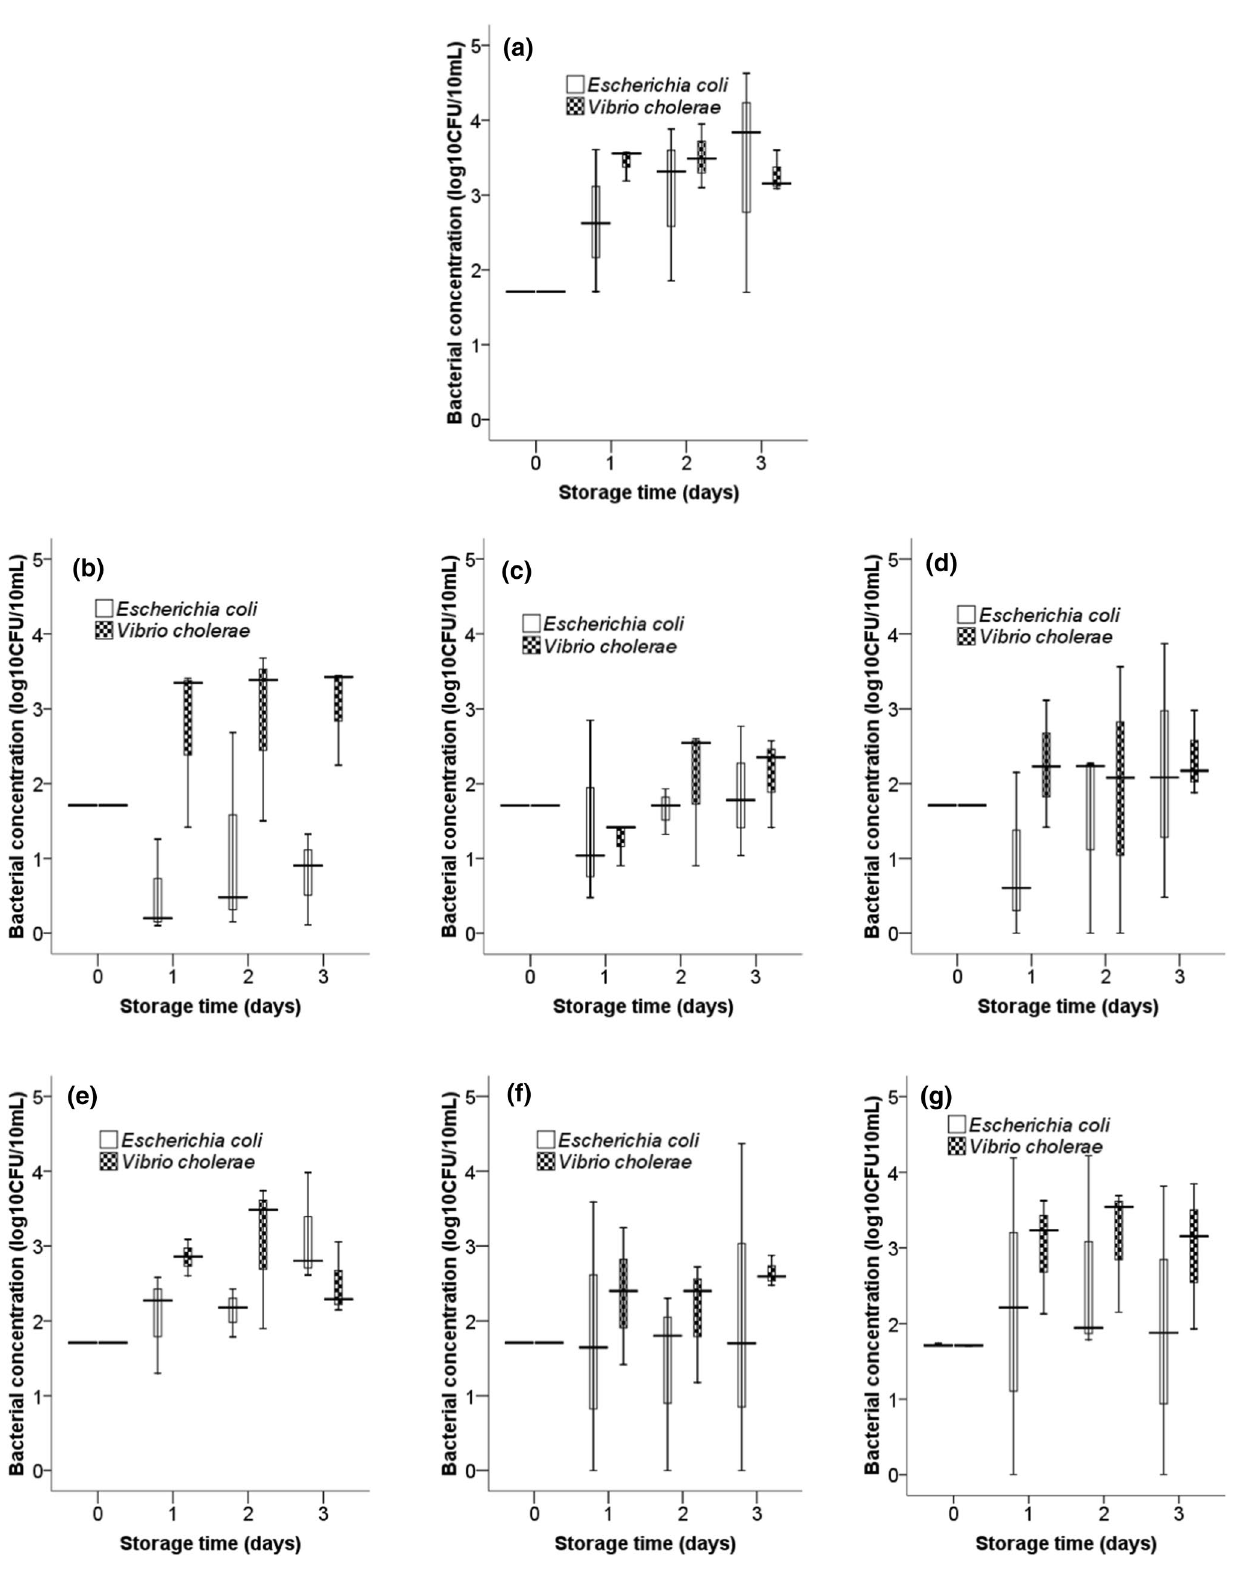
Fig. 1 Variations in concentrations of E. coli and V . cholerae inoculated separately in sterile saline a , mineral water b , chlorinated tap water c , autoclaved well water d , filtered-autoclaved well water e , filtered well water f and ozonated borehole water g during storage (Boxplot, n =